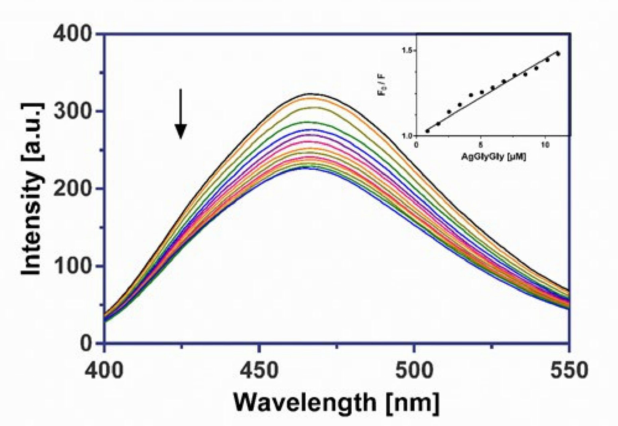
Figure 10. The emission spectra of CT DNA–HO in the presence of AgGlyAla. Arrow shows the intensity changes upon increasing the complex concentration. Inset: the corresponding Stern– Volmer plot.